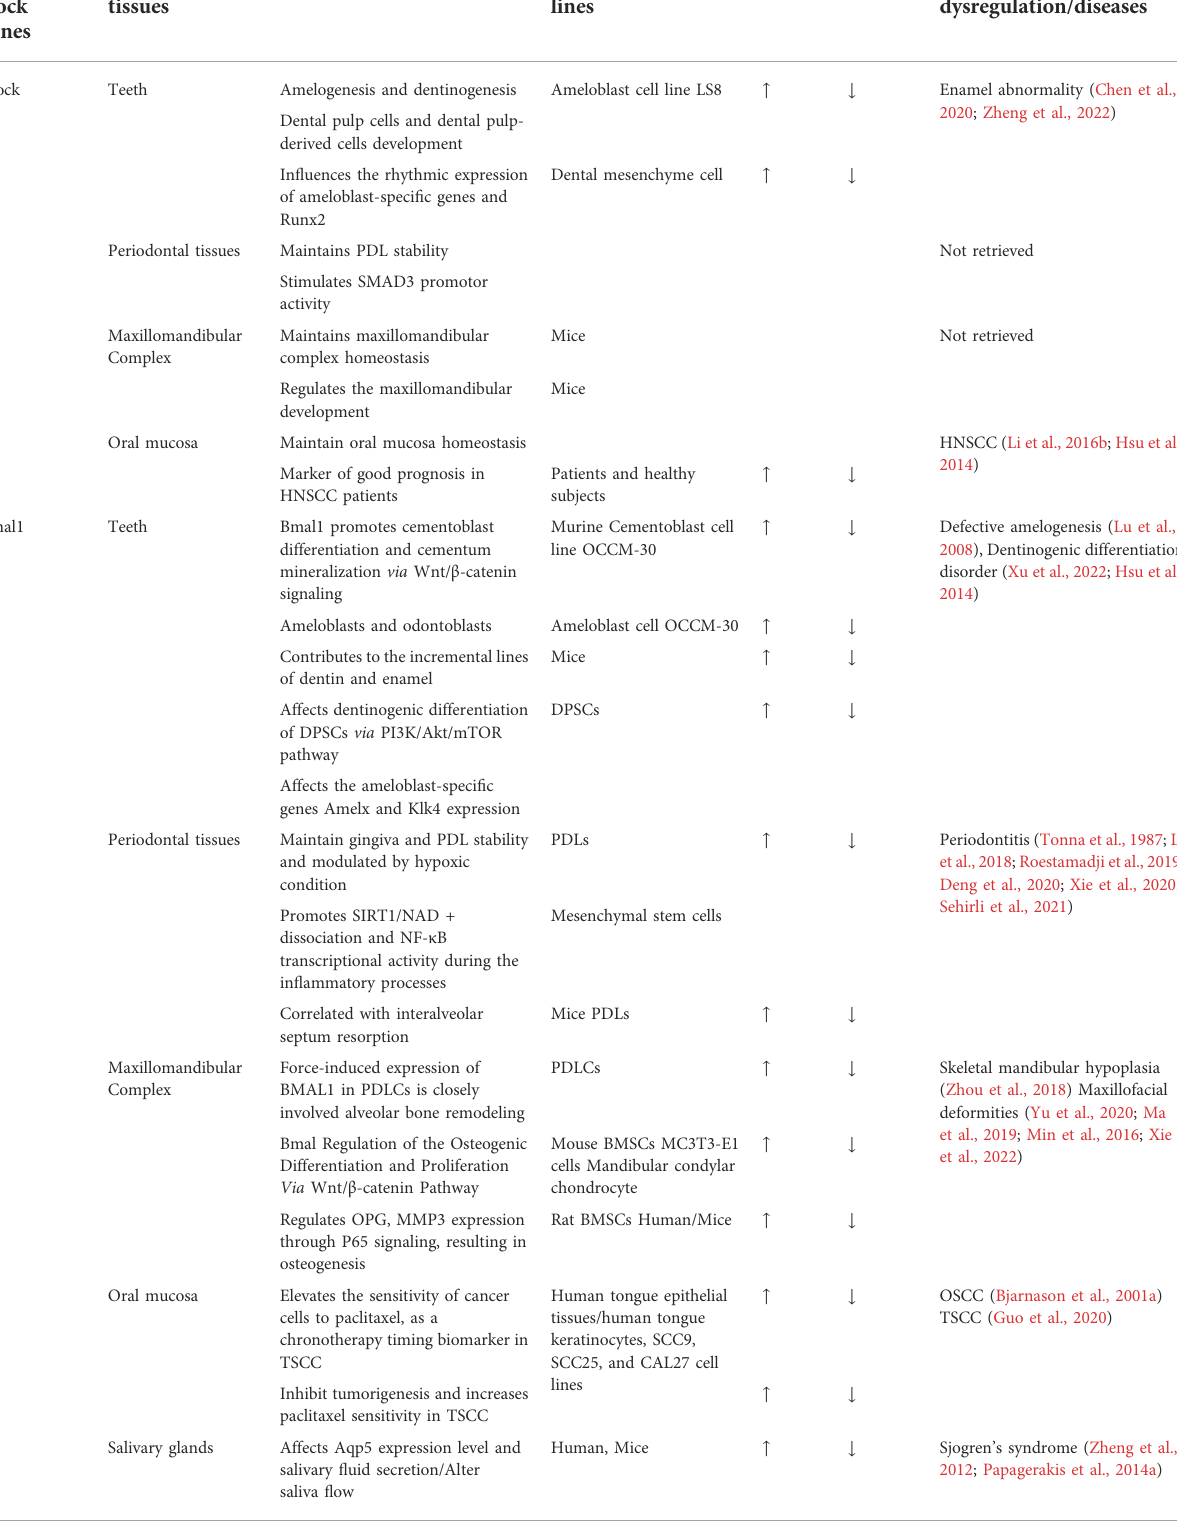
TABLE 1 Expression of circadian clock in oral-craniofacial